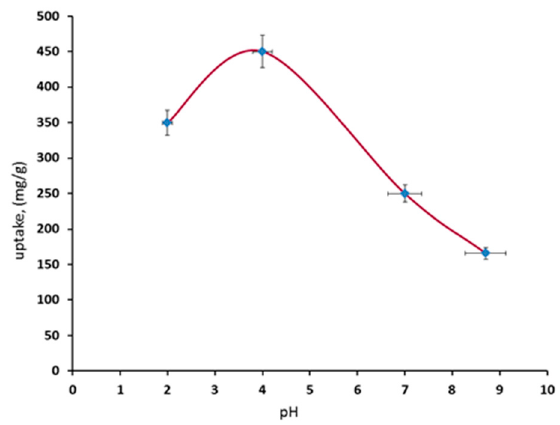
Figure 9. Uptake of Hg(II) based on pH level.